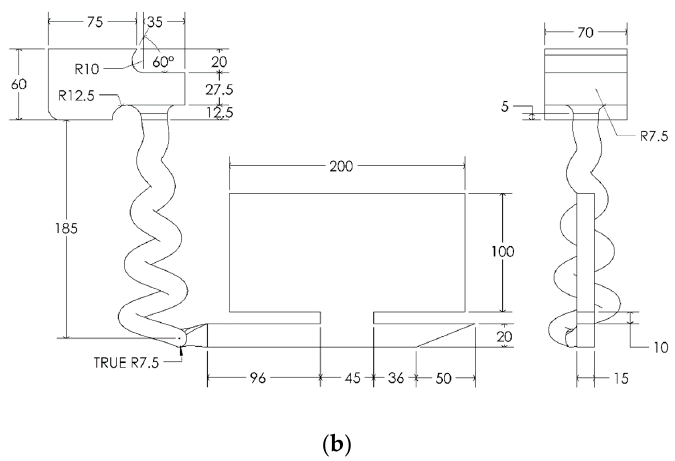
Figure 2. ( a ) Dimensions of the casting system for a straight sprued casting—SSC ( b ) Dimensions of the casting system for the conical-helix sprued casting—CHSC. All dimensions in mm.